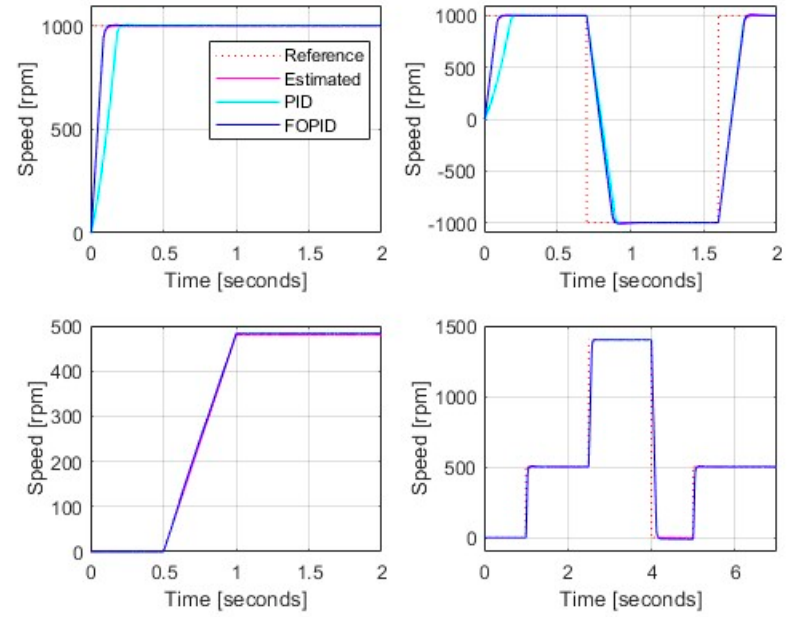
Figure 9. Rotor speed variations subjected to different reference trajectories.